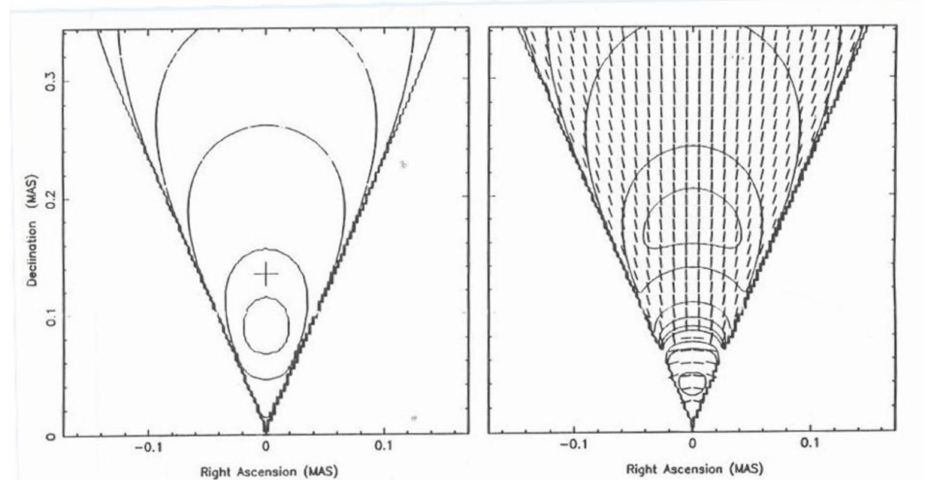
Figure 2. Contours of total intensity ( left ) and polarized intensity ( right ) for a resolved Blandford–Königl jet with a toroidal magnetic field. The cross marks the position of unit optical depth. The polarization tick marks are EVPAs. Figure 2 is also copied from